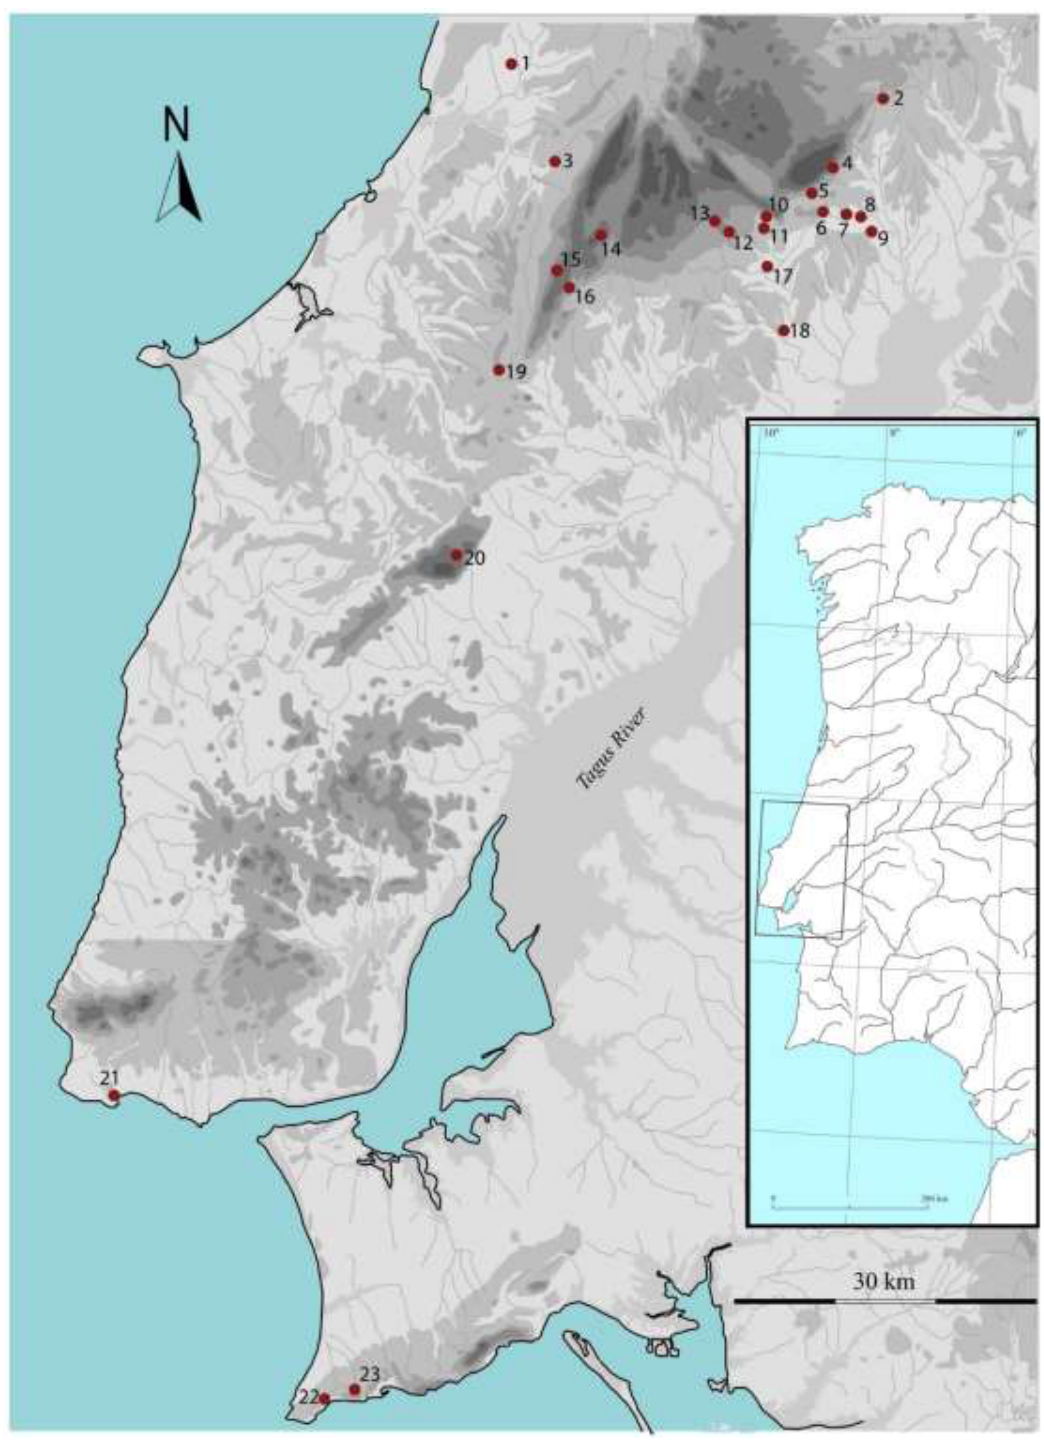
Figure 2. Lapa da Galinha (10) and the Neolithic-Chalcolithic funerary sites from the ELM and other caves mentioned in the text (cartographic base of Rui Boaventura). 1- Cova das Lapas (natural cave); 2- Buraca da Moura da Rexaldia (natural cave); 3- Grutas de Alcobaça (natural caves); 4- Lapa dos Namorados (natural cave); 5- Lapa da Bugalheira (natural cave); 6- Entrada Superior 2 da Nascente do Almonda (natural cave); 7- Ribeira Branca 1 e 2 (hypogea); 8- Necrópole das Lapas (hypogeum); 9- Convento do Carmo (hypogeum); 10- Lapa da Galinha (natural cave); 11- Fonte Moreira (Dolmen); 12- Algar do Barrão (natural cave); 13- Gruta dos Carrascos (natural cave); 14- Lugar do Canto (natural cave); 15- Anta-capela das Alcobertas (Dolmen); 16- Gruta das Alcobertas (natural cave); 17- Gruta da Marmota (natural cave); 18- Lapa do Saldanha (natural cave); 19- Grutas da Senhora da Luz (natural caves); 20- Algar do Bom Santo (natural cave); 21- Poço Velho (natural cave); 22; Lapa do Bugio (natural cave); 23- Lapa do Fumo (natural Journal of Lithic Studies (2019) vol. 6, nr. 1, p. xx-xx DOI: https://doi.org/10.2218/jls.2857